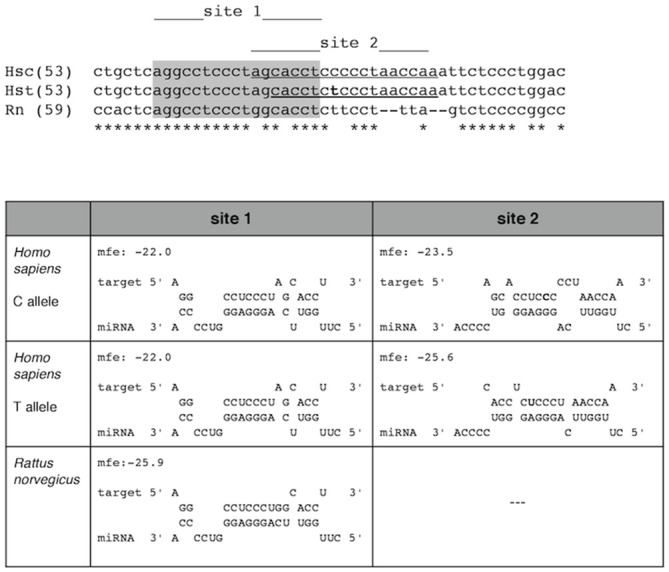
miR-659-3p binding to the GRN transcripts. Top: sequences of the human GRN 3′UTR (nt 53–111) corresponding to the C-allele (Hsc) and to the T-allele (Hst) are aligned, together with the rat GRN 3′UTR (nt 59–104). Bottom: Thermodynamics of miR-659-3p binding to the GRN 3′UTR in Homo sapiens and Rattus norvegicus. In human two target sites are found (site 1 and site 2). Binding to site 2 is thermodinamically favored. The presence of the risk T-allele in site 2 results in a stronger binding (DeltaG = −25.6 kcal/mol) compared to the C-allele (DeltaG = −23.5 kcal/mol). In rat only site 1 is present, and is predicted to bind with energy similar to that of the T-allele in the human transcript (DeltaG = −25.9 kcal/mol). mfe, minimum free energy change (DeltaG).